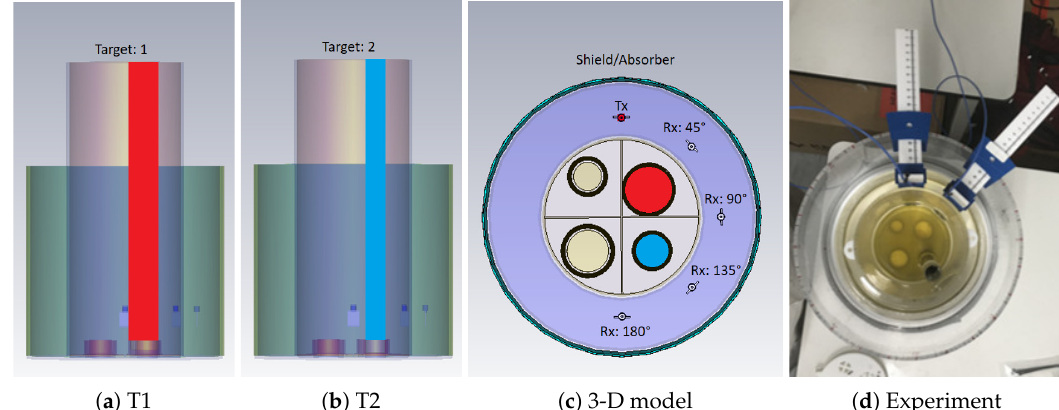
Figure 1. The modelled 3-D simulated and experimental configuration used to observe the transmitted signal differences caused by different dielectric targets: Drawings of ( a ) Target T1 (r = 15mm), ( b ) Target T2 (r = 10mm), and ( c ) the 3-D model used in simulations; ( d ) Photo of the experimental setup shown in these